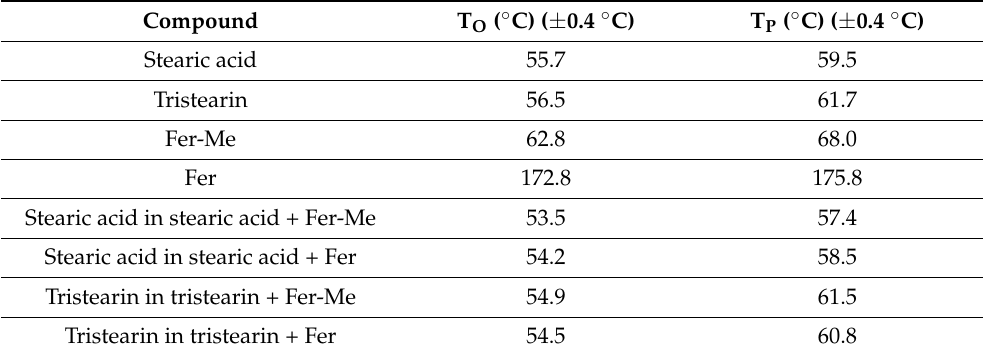
Table 2. Melting onset T O and peak T P temperature for the different pure compounds and for the lipid phase melting transition in the different